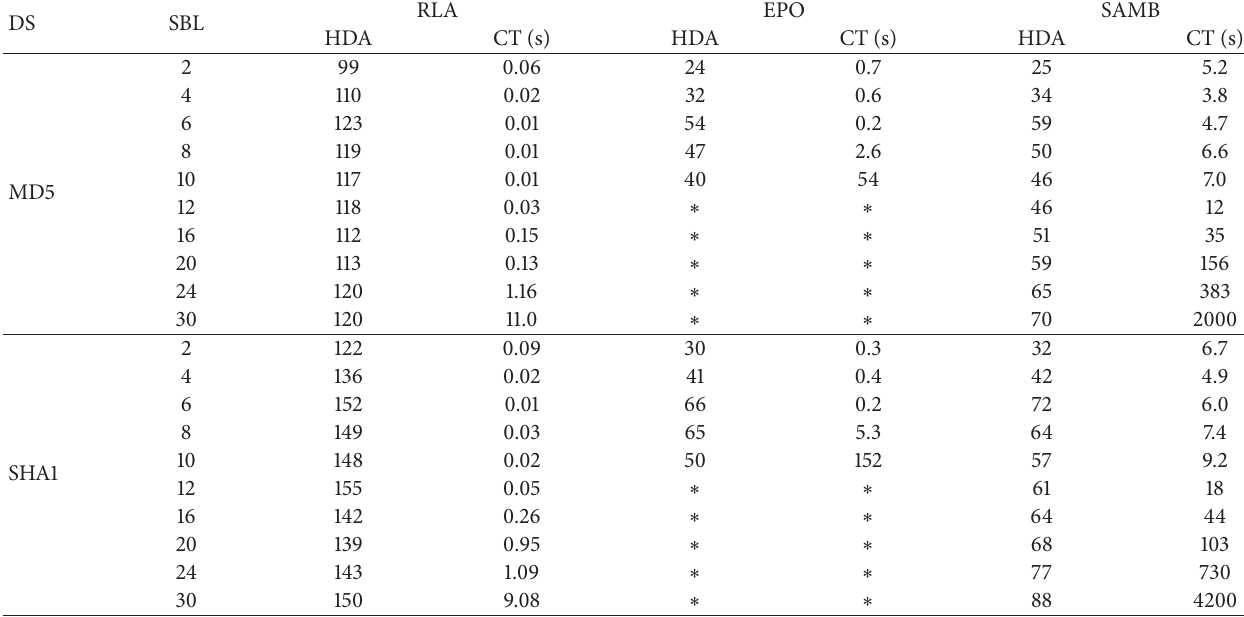
Table 2: HDAs and CTs (PentiumIV at 2.2 GHz) with the automated tool for the linear combination as combinational logic ( ∗ resources